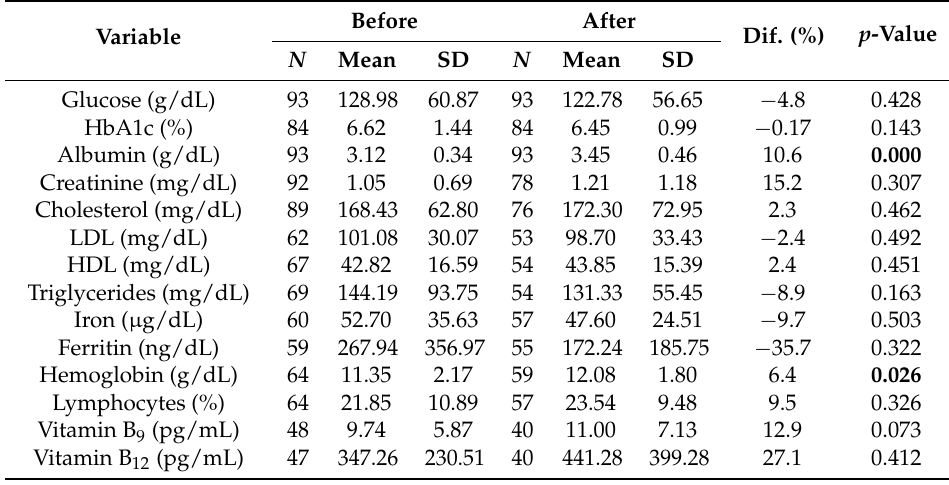
Table 2. Sample clinical variables mean values before and after the prescription of the enteral nutrition. Before Variable